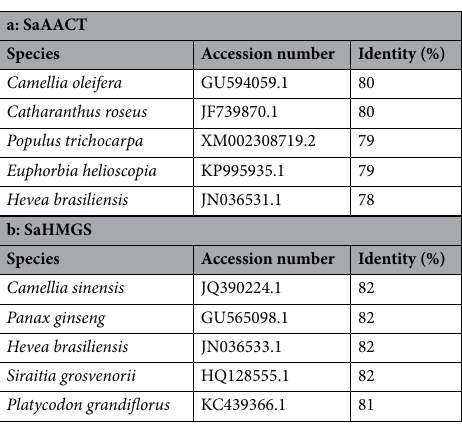
Table 2. Nucleotide sequences of target genes and similarity to genes from other plant